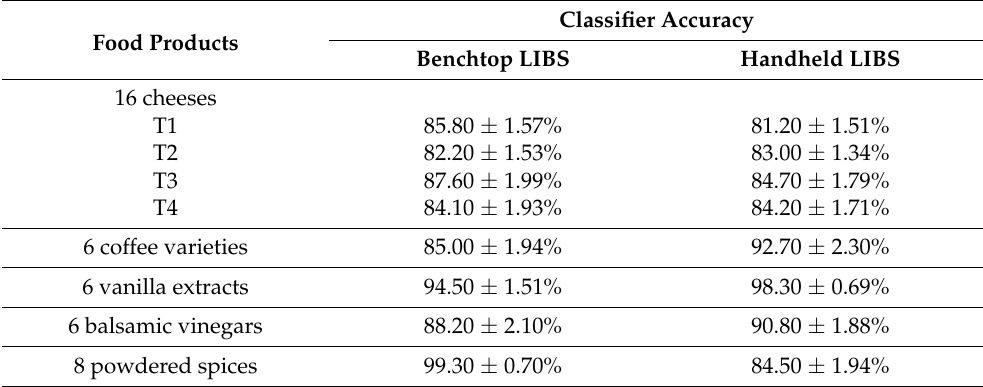
Table 3. ENET classification accuracy of five different food products measured by the benchtop and handheld LIBS systems at four different time